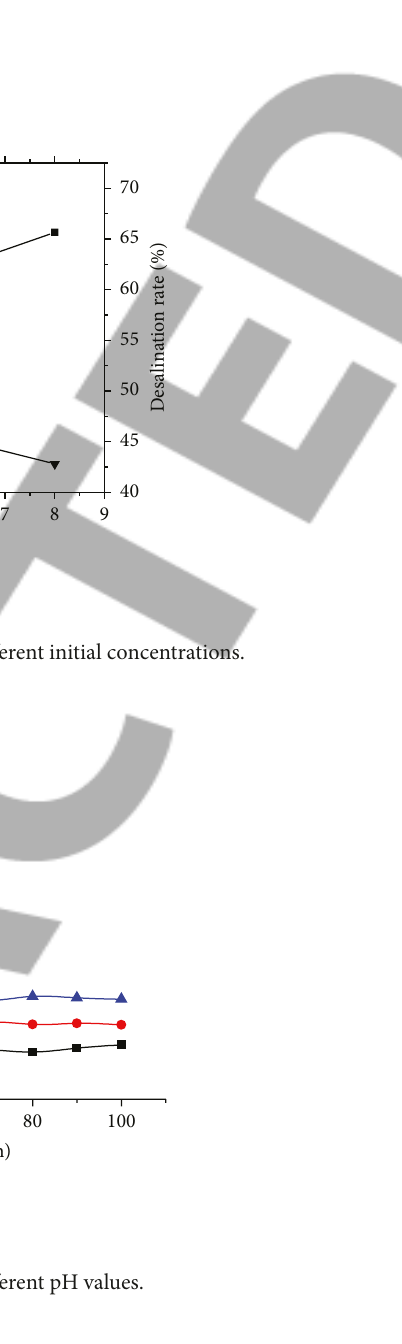
Figure 8: The outlets’ conductivities at different pH